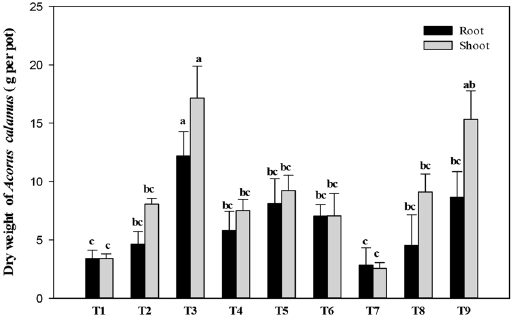
Figure 1. Dry weight of Acorus calamus was significantly influenced by polycyclic aromatic hydrocarbons (PAHs), but not by cadmium (Cd), or the interaction between the two, after 60 days of growth. Bars (mean ± SE, n = 3) with different letters (a,b,ab,bc) are significantly different based on the least significant difference test (p < 0.05). Treatments: C0P0 (T 1 ), C0P1 (T 2 ), C0P2 (T 3 ), C1P0 (T 4 ), C1P1 (T 5 ), C1P2 (T 6 ), C2P0 (T 7 ), C2P1 (T 8 ), and C2P2 (T 9 ). C0, C1, and C2 represent 0, 10, and 20 mg Cd kg − 1 ; P0, P1, and P2 represent 0, 50 + 25, and 100 + 50 mg PAHs kg − 1 with PHN + PYR,